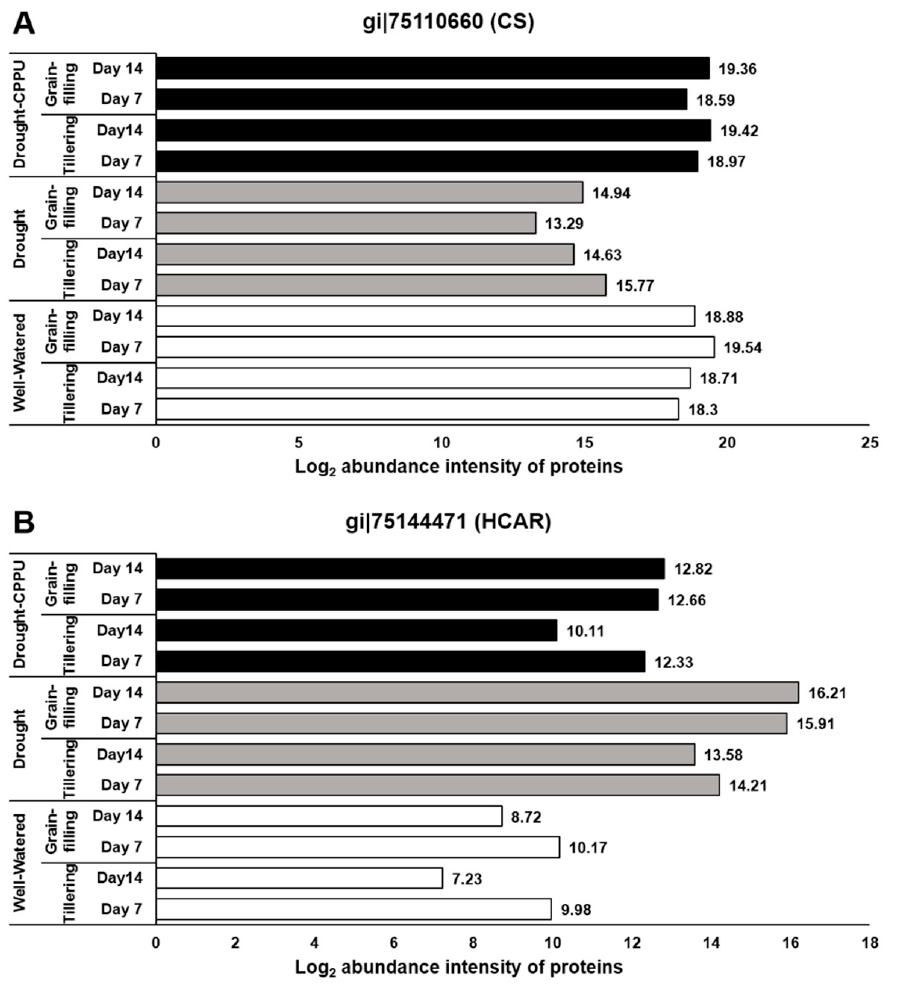
Figure 7. The influence of synthetic cytokinin and drought on the abundance intensities of ( A ) chlorophyll synthase (CS) and ( B ) 7-hydroxymethyl chlorophyll a reductase (HCAR) proteins involved in biosynthesis/degradation of chlorophyll pigments at tillering and grain-filling stages of the rice. Protein abundance intensities, represented on the X- axis, are the highest log2 fold change values of technical replicates. [Well-Watered plants were maintained at a soil moisture tension of − 15 kPa during the treatment period. Drought stress was imposed by withholding water for up to 14 days. Soil moisture tensions of − 55 kPa and − 72 kPa were recorded at day 7 and day 14 during the treatment, respectively. CPPU treatment was given by foliar spraying plants with a 5 mg/L solution of CPPU at the rate of 25 mL/plant on day 6 of drought treatment.].